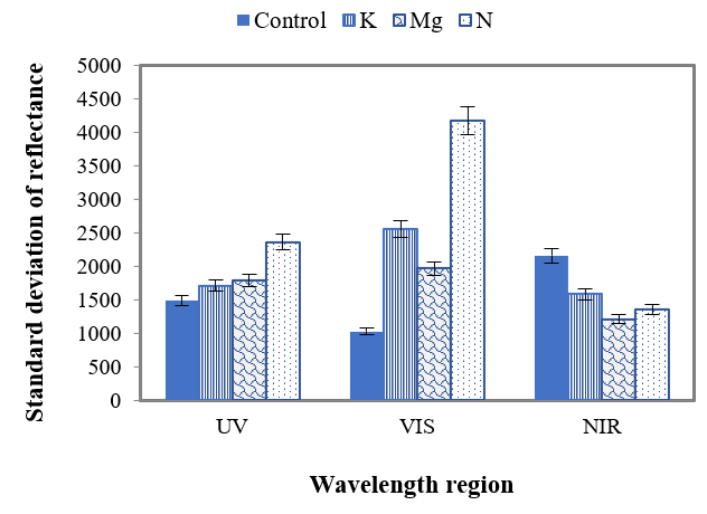
Figure 12. A plot of SD of control and different nutrient-deficient leaves in UV, VIS and N.I.R. regions, representing the difference between control and nutrient-deficient leaves in different wavelength regions. difference value is higher in the VIS region compared to